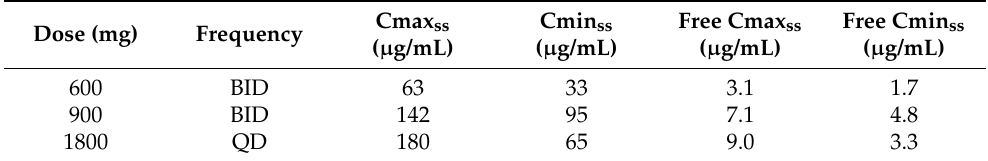
Table 1. Probenecid steady-state concentration and free drug concentrations after different probenecid